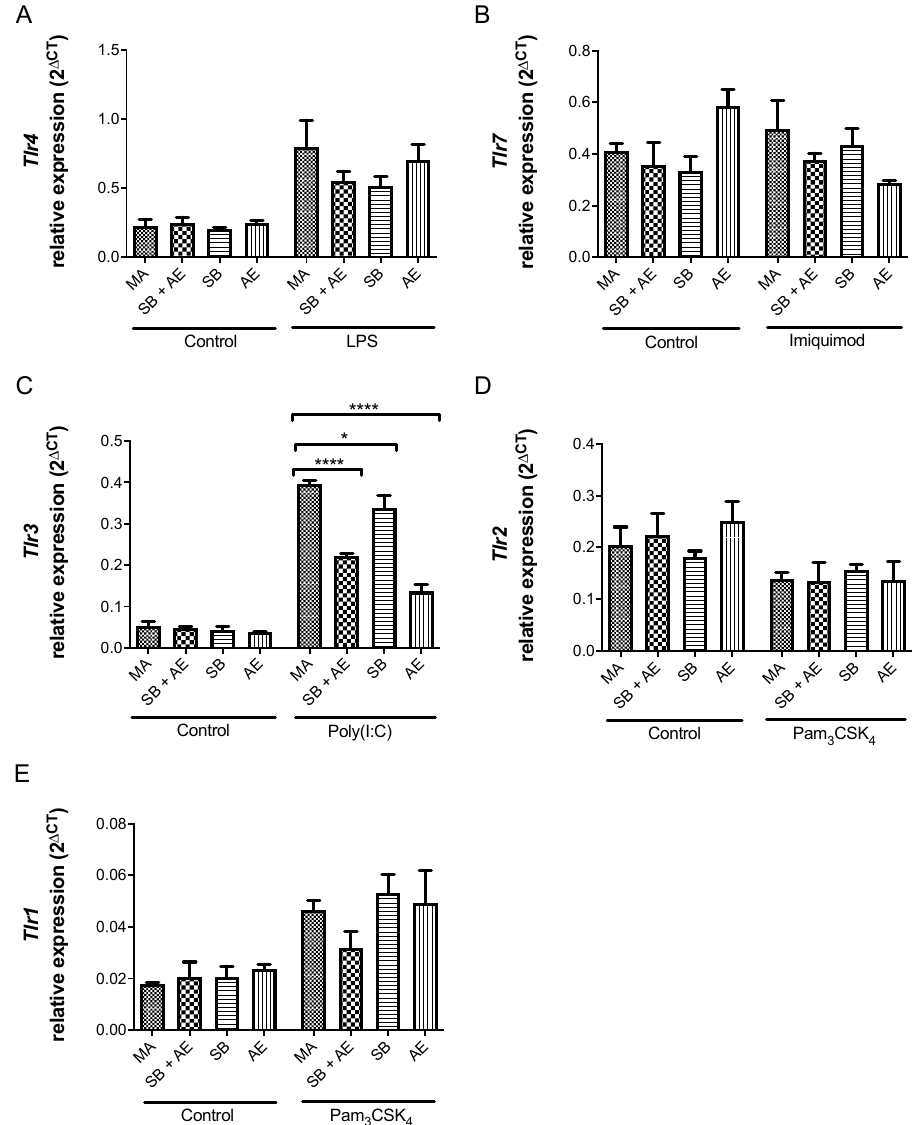
Figure 7. Relative gene expression of Tlr 4 ( A ), Tlr7 ( B ), Tlr3 ( C ), Tlr2 ( D ) and Tlr1 ( E ) mRNAs by qRT-PCR in RAW 264.7 cells cultured over the Ti-discs with different surfaces: mechanical abrasion (MA), sandblasting plus etching (SB + AE), sandblasting (SB) and acid etching (AE) and with or without the TLR ligands LPS (TLR4), Imiquimod (TLR7), Poly(I:C) (TLR3) and Pam3Csk4 (TLR2/1). *, p < 0.00332; ****, p <